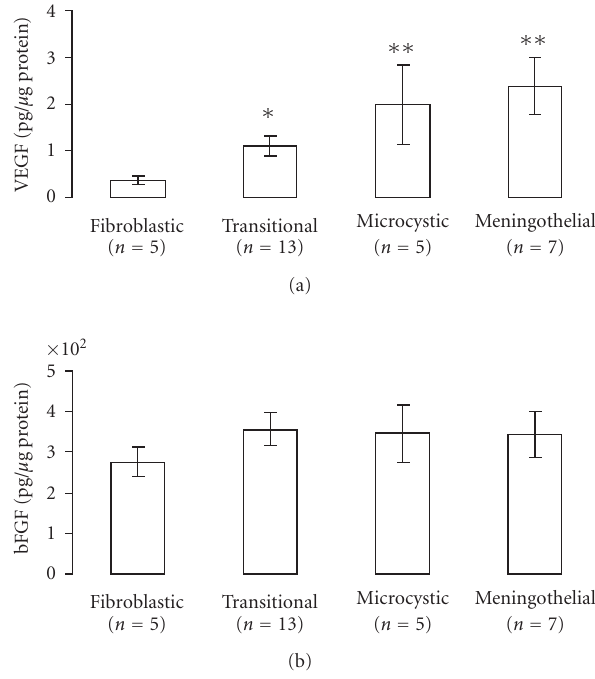
Figure 1: VEGF and bFGF contents in various subtypes of grade I meningiomas VEGF (upper panel) and bFGF (lower panel) con- tents were determined by ELISA. Results (in pg/ µ g of protein) are reported as means ± SEM. n denotes the number of patients. For transitional meningiomas: VEGF range [0 . 25–9 . 85] and bFGF range [67 . 4–576 . 9]; for microcystic meningiomas: VEGF range [0 . 71–5 . 29] and bFGF range [164 . 3–520 . 0]; for meningothelial meningiomas: VEGF range [0 . 87–4 . 98] and bFGF range [183 . 6– 573 . 7]; for fibroblastic meningiomas: VEGF range [0 . 10–1 . 69] and bFGF range [142 . 1–377 . 3]. ∗ P < . 04 and ∗∗ P < . 01 as compared with fibroblastic meningiomas. Statistical analysis was performed using the Mann-Whitney U test.